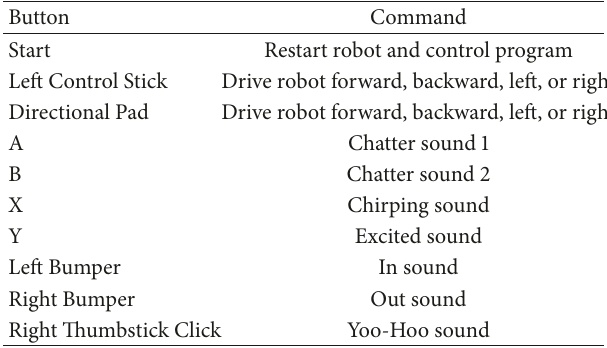
Table 1: Controller commands for the